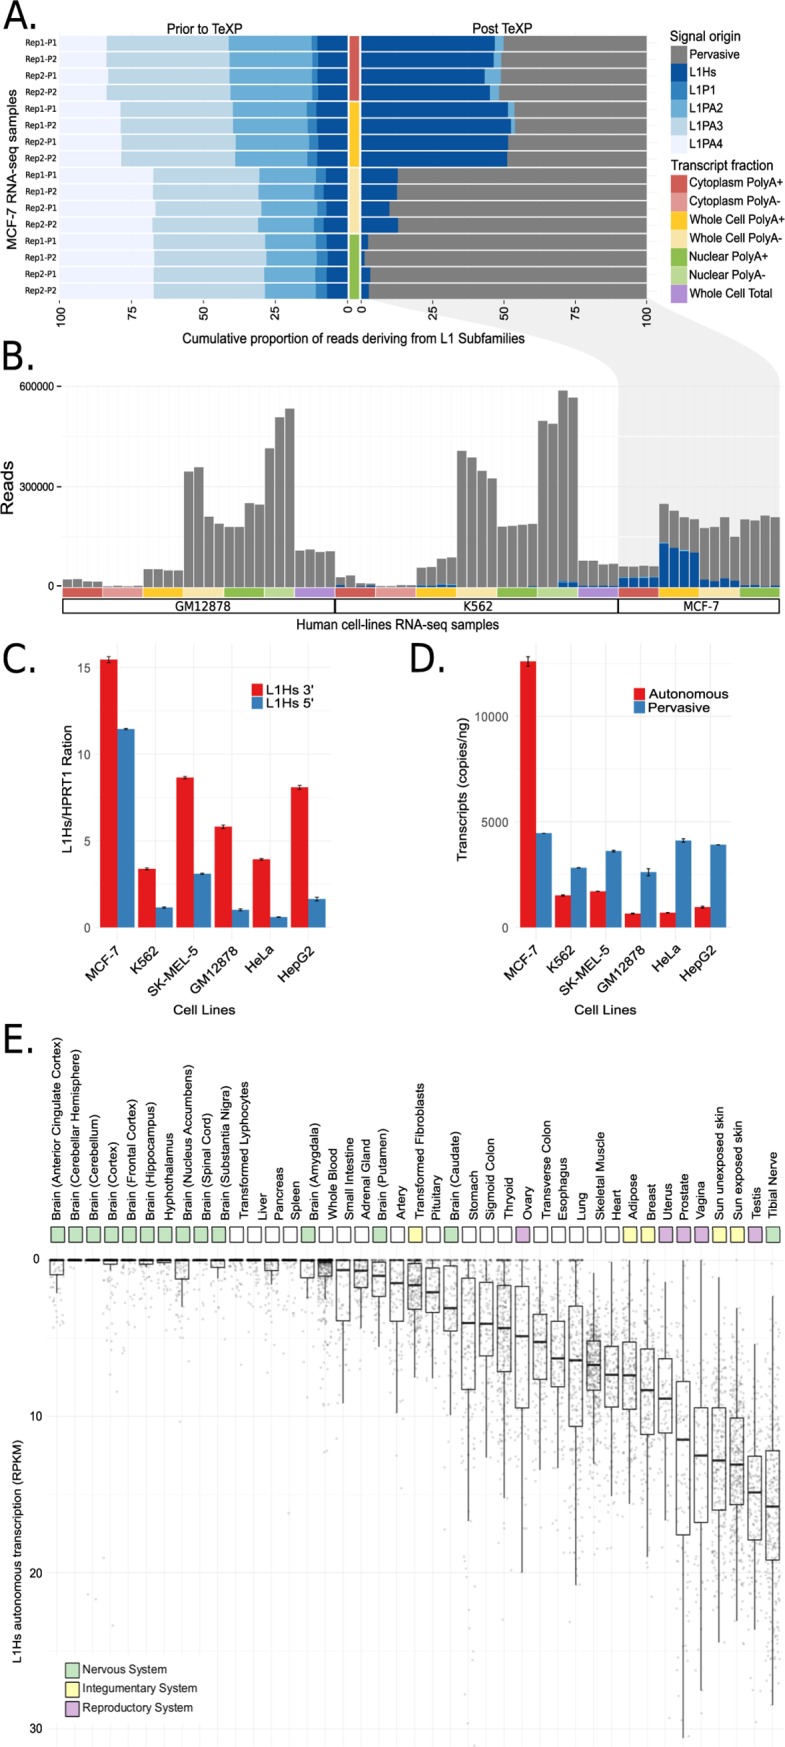
Quantification and validation of L1Hs autonomous transcription in human cell lines.(A) The proportion of reads emanating from pervasive transcription and L1P1, L1PA2, L1PA3, L1PA4, and L1Hs subfamilies in MCF-7 RNA sequencing experiments are shown from the different cell compartments and transcript fractions prior to (left) and after (right) TeXP processing. (B) The absolute number of reads emanating from pervasive transcription and LINE-1 subfamilies are shown across the distinct cell and transcript fractions of the human-derived cell lines GM12878, K-562, and MCF7. (C-D) The quantification of autonomous and pervasive transcripts of L1Hs in the cell lines is shown using ddPCR. (C) The ratio of L1Hs 5’ and 3’ transcripts shows the enrichment of the 3’ end of L1Hs for all cell lines. (D) The absolute quantification of autonomous and pervasive transcripts reveals higher expression of pervasive compared to autonomous transcripts in all cell lines except MCF-7. All data were run in duplicate. All errors bars are mean ± SEM. These data represent two independent experiments. (E) L1Hs autonomous transcription landscape of human healthy primary tissues. Each point is a RNA sequencing experiment, separated by tissue of origin.